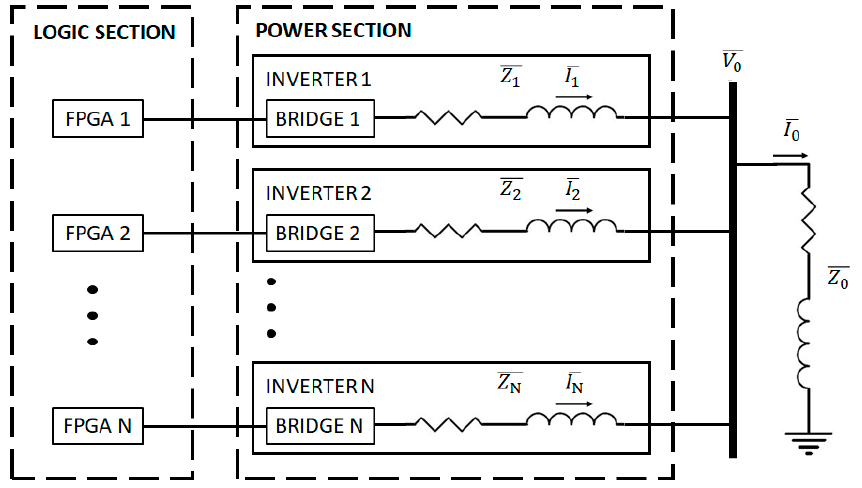
Figure 1. Schematic of a general parallel-connected inverter system.